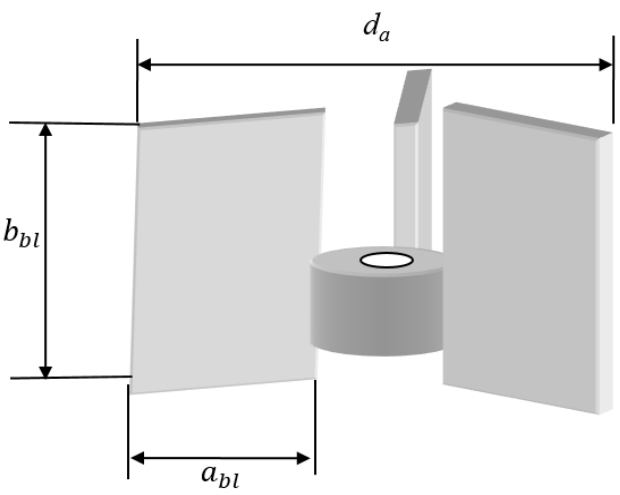
Figure 14. Geometric parameters of blades.